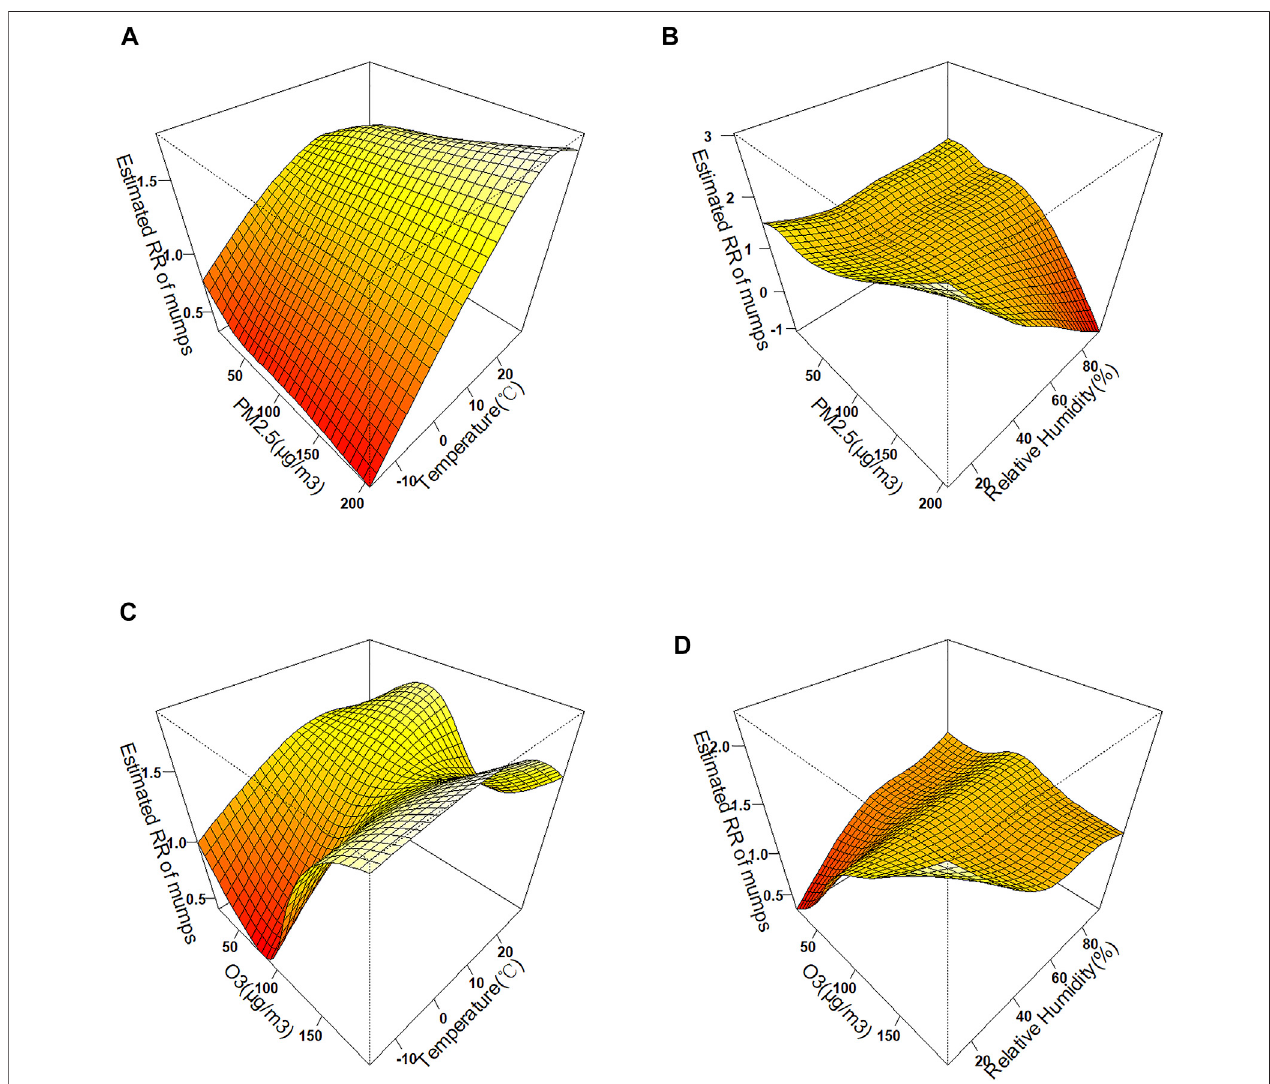
FIGURE 2 | Bivariate response surfaces of meteorology and air pollutants in Ningxia, China, 2015 – 2019. (A) For temperature and PM 2.5 ; (B) for relative humidity and PM 2.5 ; (C) for temperature and O 3 ; and (D) for relative humidity and O 3